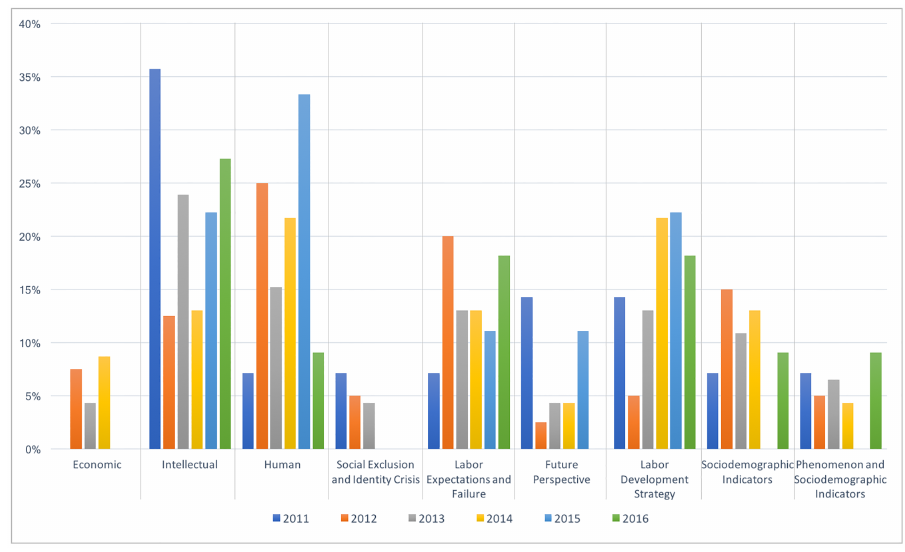
Fig 2. International assessment of the phenomenon proportion by